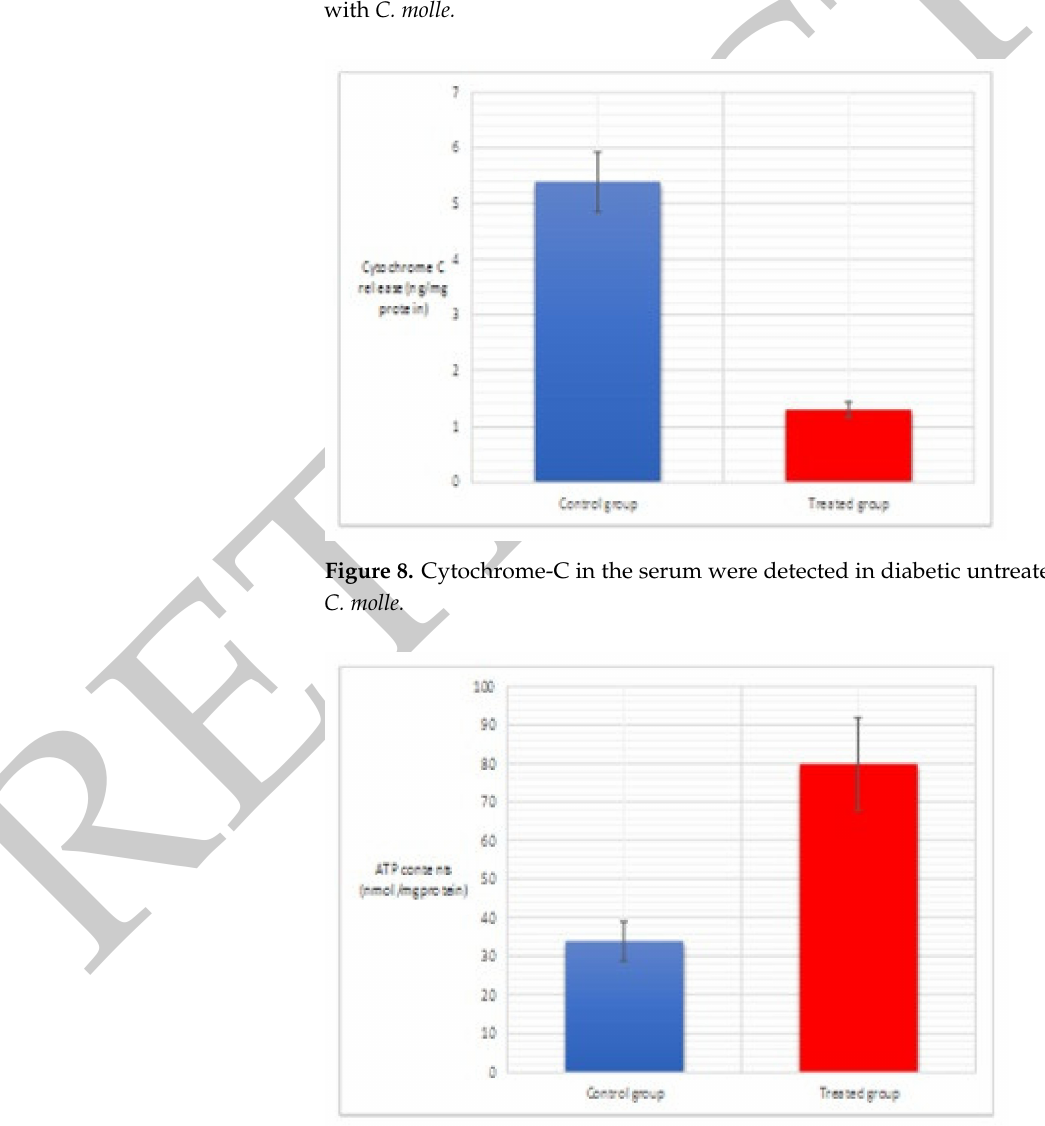
Figure 9. ATP in the serum were detected in diabetic untreated and treated group with C.